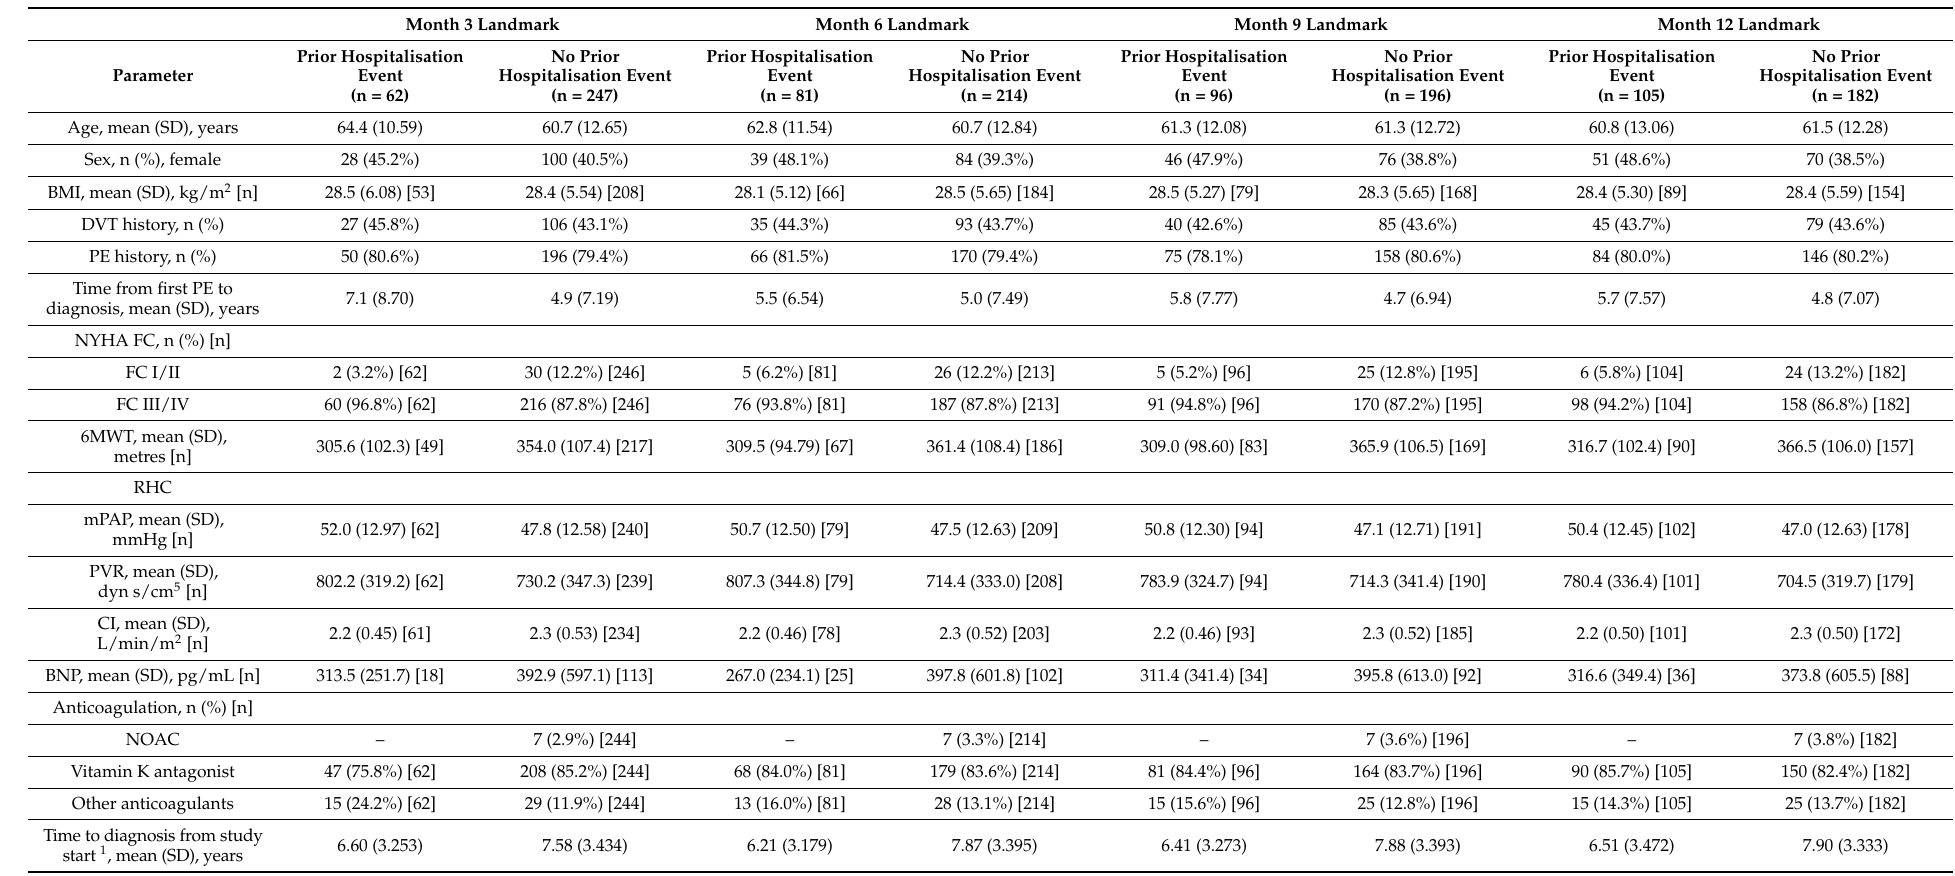
Table 2. Baseline characteristics of operable patients at landmark